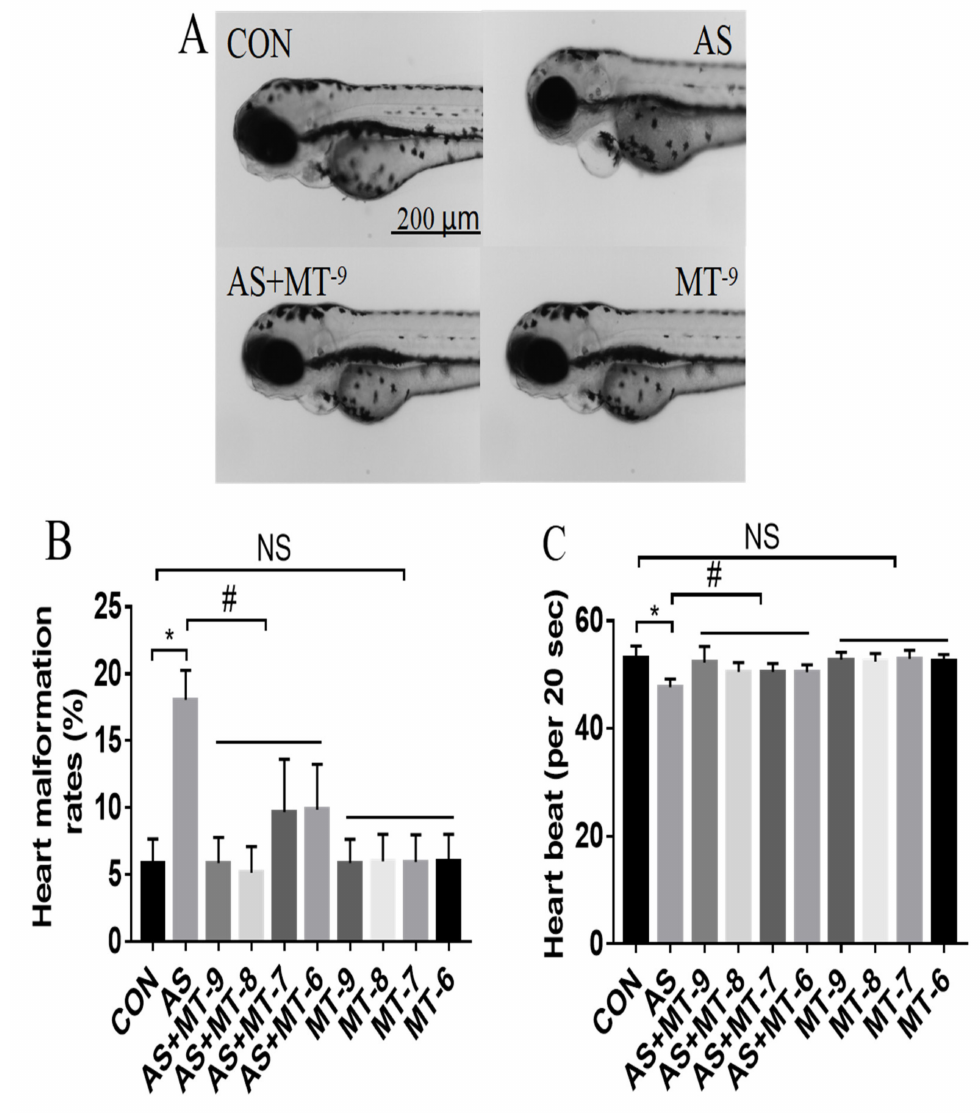
Figure 1. The effects of melatonin on the NaAsO 2 -induced heart malformations in zebrafish embryos at 72 hpf. ( A ) Images of zebrafish. ( B ) Heart malformation rate. ( C ) Heart rate. CON: system water as the vehicle control; AS: NaAsO 2 at 1.0 mM; MT − 9 , MT − 8 , MT − 7 , MT − 6 : Melatonin at 10 − 9 , 10 − 8 , 10 − 7 , 10 − 6 M; * p < 0.05, compared to CON; # p < 0.05, compared to MT; NS, compared to